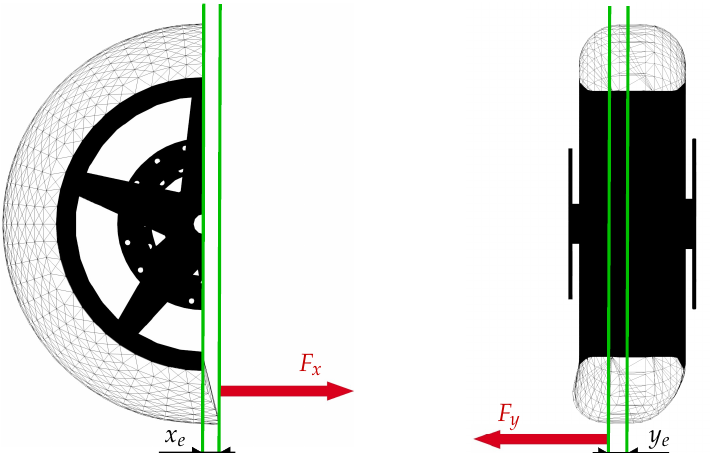
Figure 2. Longitudinal an lateral deflections in a toroidal tire due to tangential